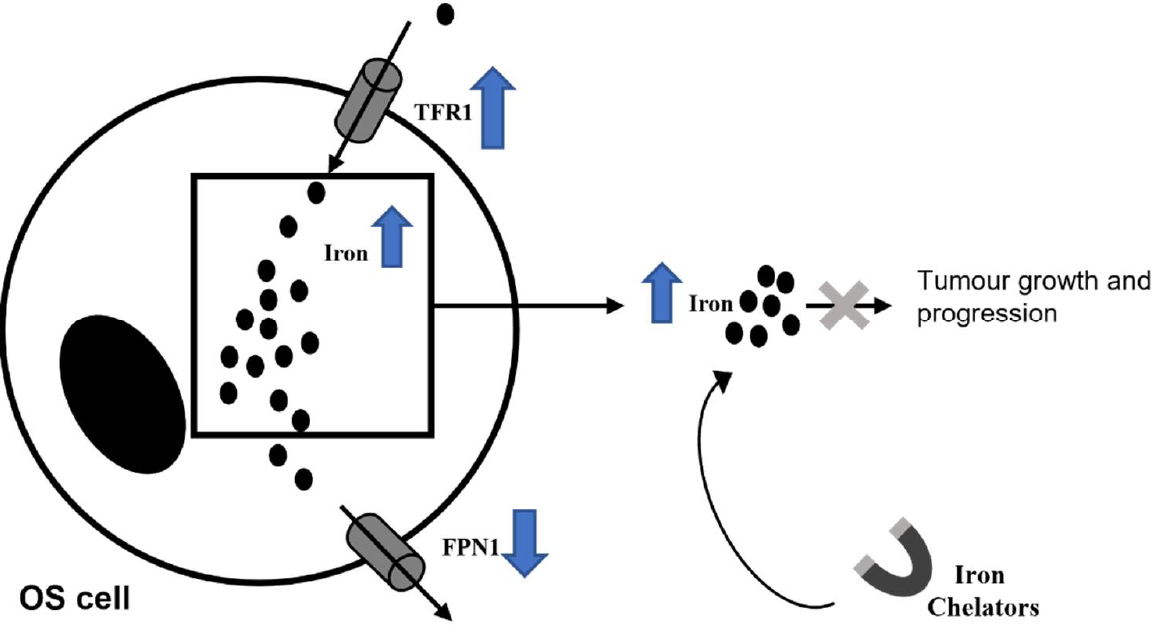
Figure 4. Iron chelators, by sequestering iron, exert anti-cancer properties.